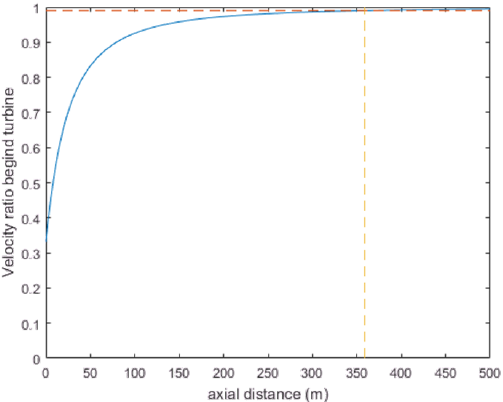
Fig. 11. Trend of the wake velocity loss in function of the distance behind the turbine, assuming a wake decay factor 𝑘 𝑤 =0.05. (The vertical line indicates a recovery of 99% of the undisturbed current